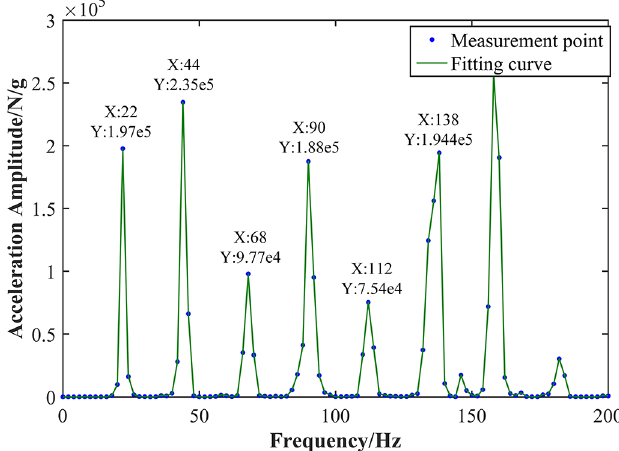
Fig. 10. Experimental results of the saw blade